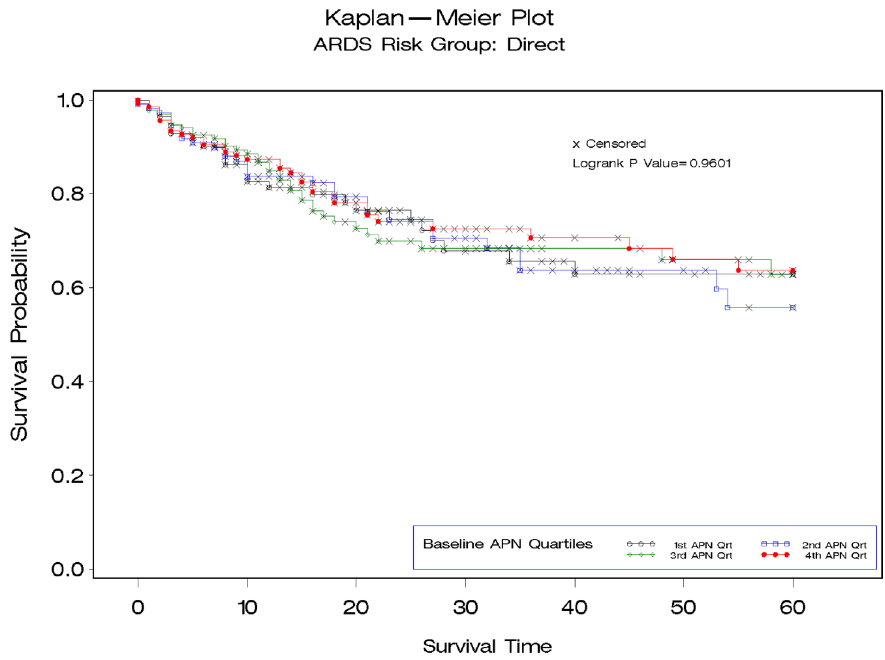
Figure 3. Kaplan-Meier survival plots demonstrating 60-day mortality for patients with acute respiratory distress syndrome stratified by quartile of baseline adiponectin (APN) level for patients with direct lung injury (N=494).